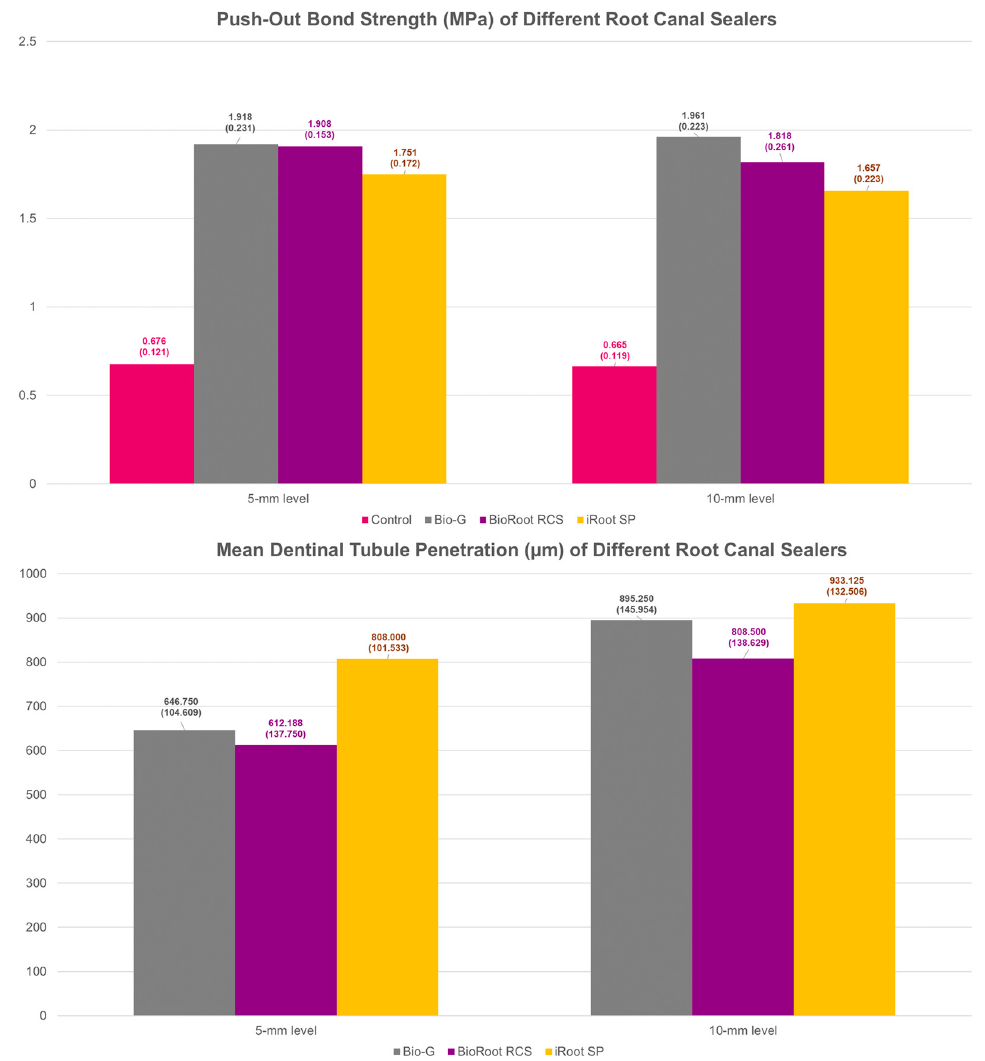
Figure 2. Mean push-out bond strength (MPa) and mean dentinal tubule penetration (µm) of Bio-G, BioRoot RCS, iRoot SP, and the control group.